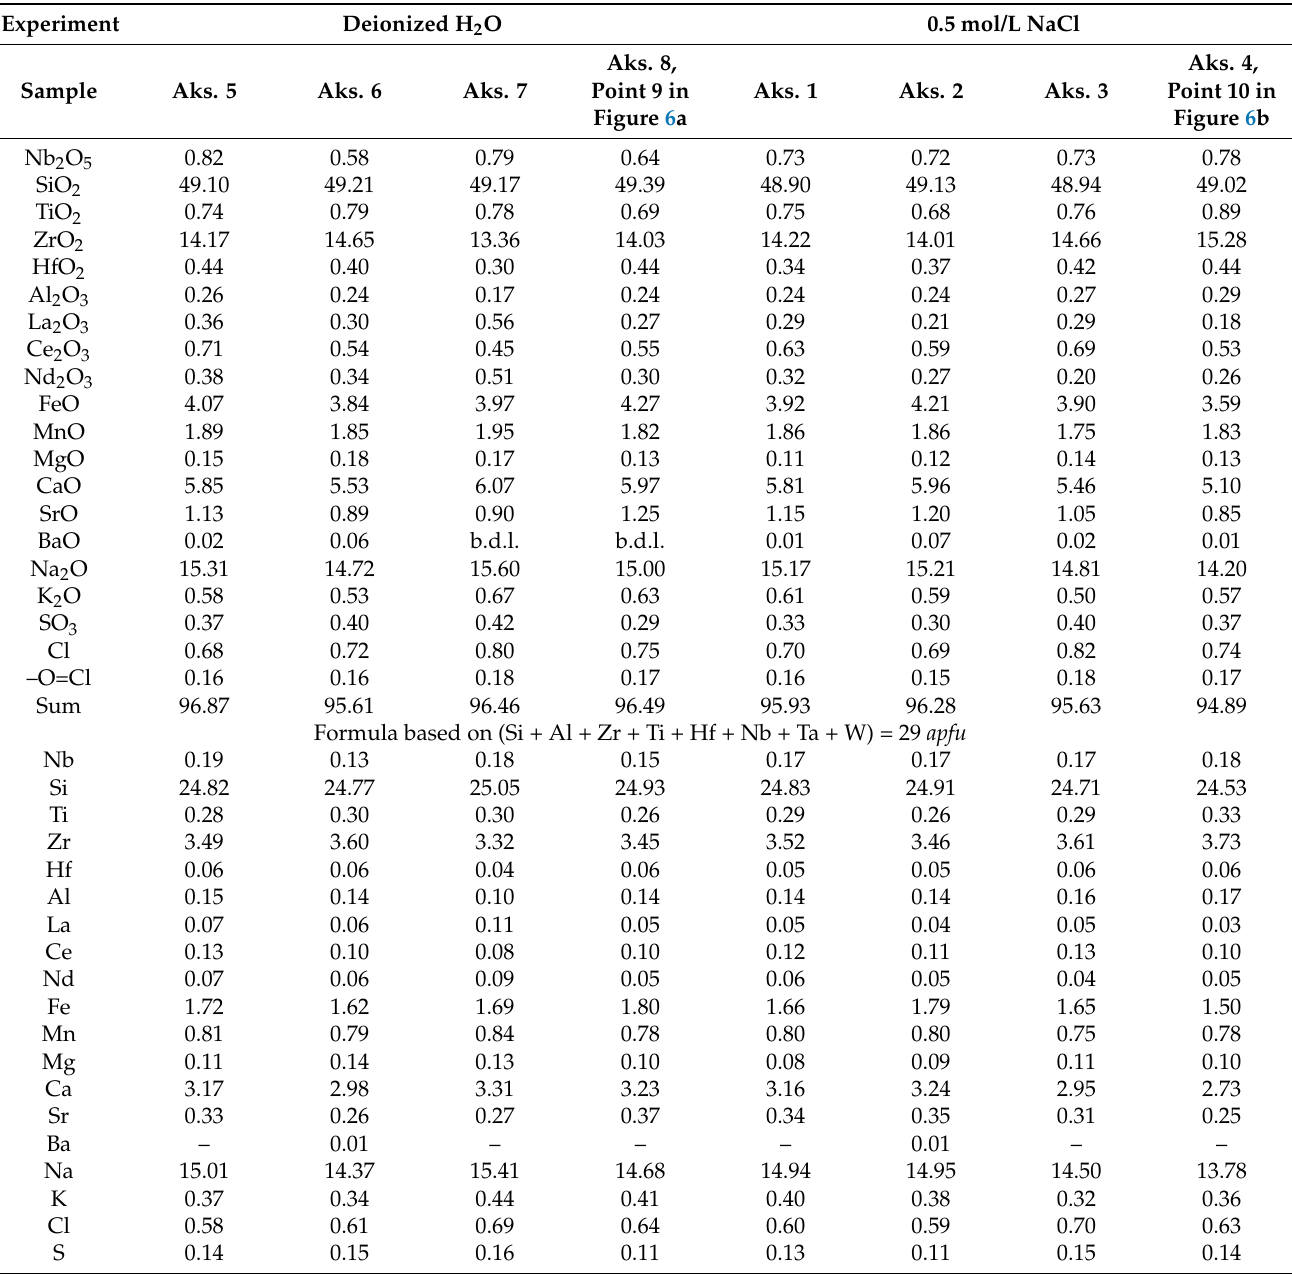
Table 4. Representative chemical analyses of EGM after experiments with both water and NaCl